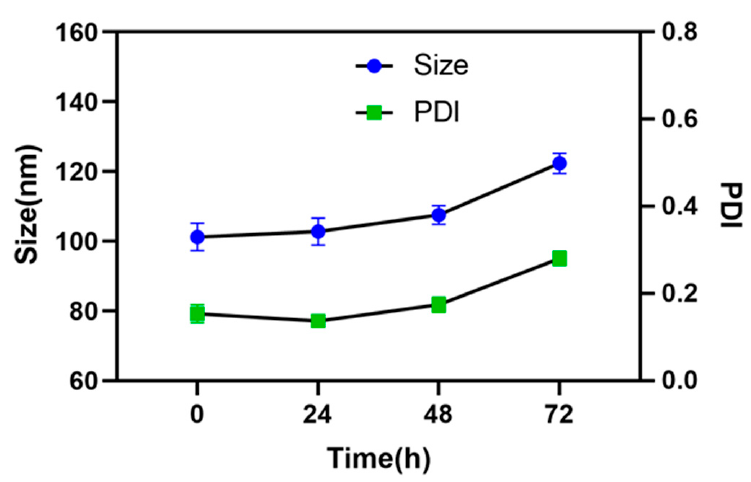
Figure 5. The result of stability of MMC RGD-NPs in 4 ◦ C within 72 h. In order to demonstrate the formation of hydrogen bonding between MMC and Fmoc- Lys-PEG, FTIR analysis of the MMC, the FACS Calibur flow cytometer, and MMC NPs were also carried out. As shown in Figure S3, the peaks of MMC are mostly coincident with Fmoc-Lys-PEG, and the amides peak of the NPs was 3429.3 cm − 1 (N-H), 1711.1 cm − 1 (amide I), 1548.3 cm − 1 (amide II), and 1250.9 cm − 1 (amide III), while the amides peak of the MMC-NPs was shifted to 3421.3 cm − 1 (N-H), 1711.1 cm − 1 (amide I), 1529.4 cm − 1 (amide II), and 1243.2 cm − 1 (amide